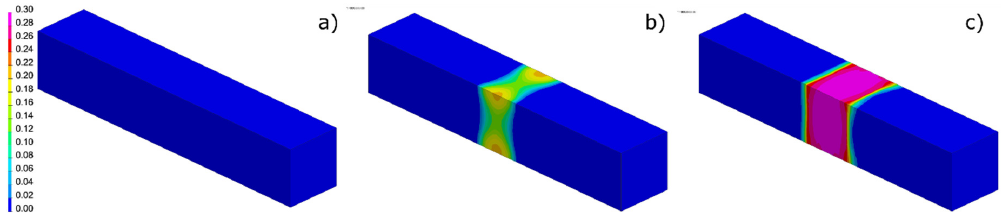
Figure 11. The calculated ferrite distributions for a thermal cycle with a maximum temperature of: ( a ) 400 °C, ( b ) 900 °C and ( c ) 1200 °C (Table 6). Table 6. The content of individual metallurgical phases calculated for simulation of sample heating depending on the maximum values of the set temperature of the thermal cycle (Table 3, Figures 9–11). Phase / Cycle